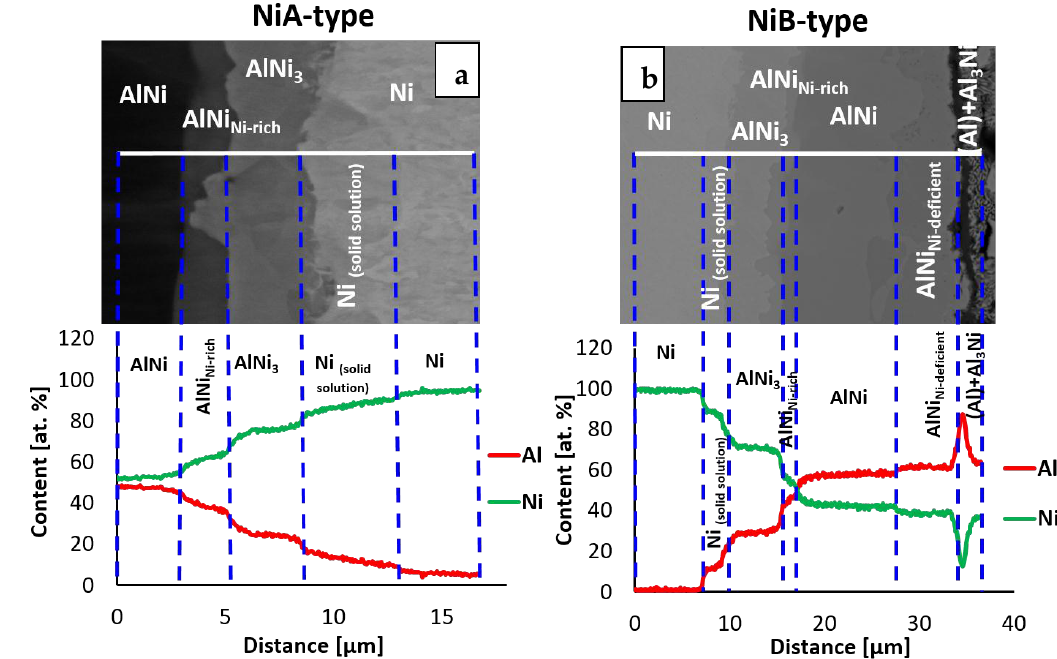
Figure 6. SEM micrographs of the cross-sectional view of a Ni/Al/Ni interconnections after 5 h of reaction time at 720 °C and EDS line-scan across this area for substrates of A-type ( a ) and B-type ( b ).